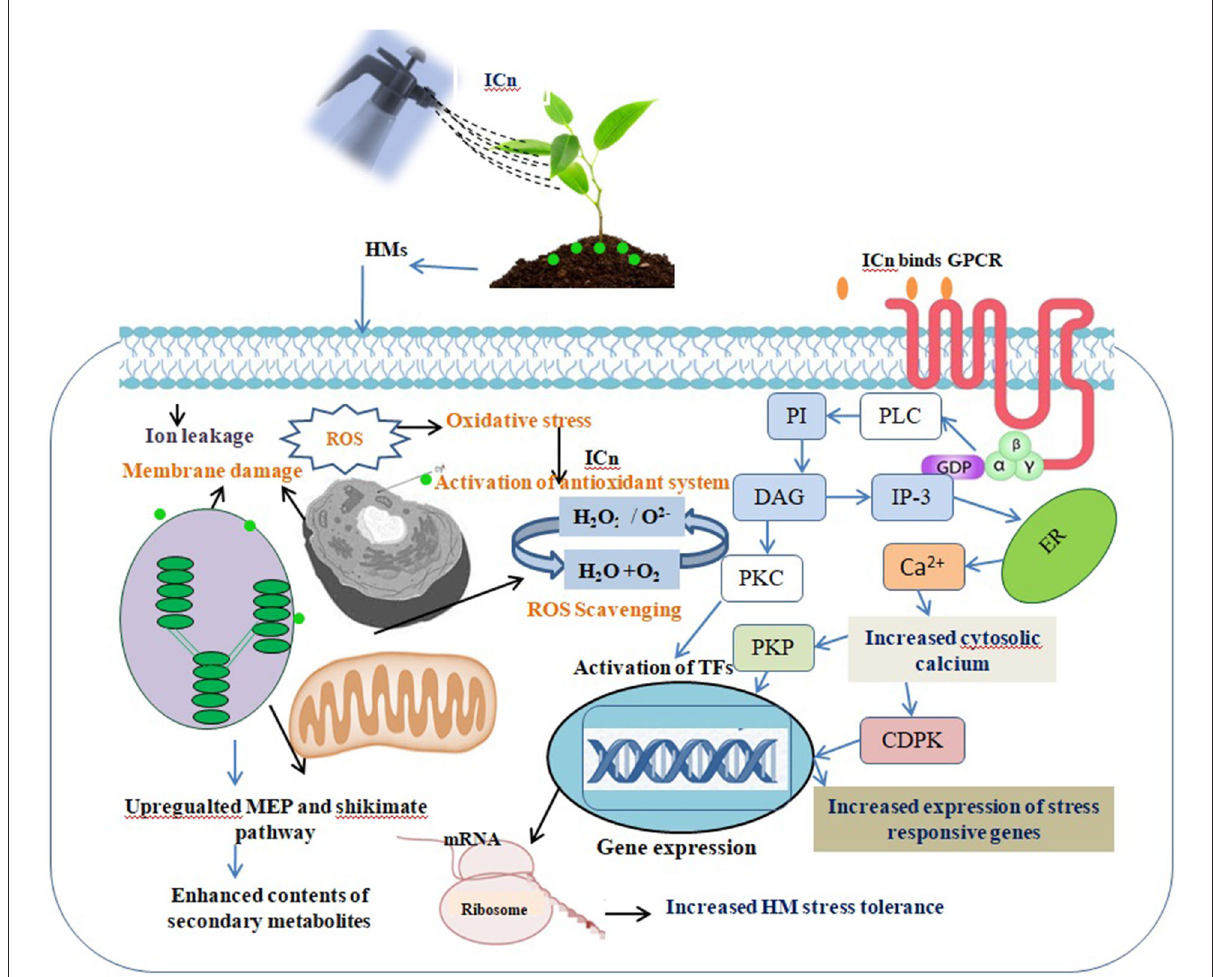
FIGURE6 Irradiated chitosan (ICn) binds to the plasma membrane receptors transmitting the signal through protein kinase (PK). ICn detoxifies the disproportionate ROS produced due to arsenic (As) stress by increasing the expression of antioxidative enzymes. Activation of phospholipase C (PLC) and G-protein signaling pathways enhances the concentration of cytosolic Ca 2 + , which, consequently, activates cell-dependent protein kinase (CDPK) and protein kinase phosphatase (PKP). These activated proteins stimulate various transcription factors, which in turn stimulates the expression of various gene response elements, leading to stimulation of different secondary metabolism pathways in As-stressed peppermint [19, 27,